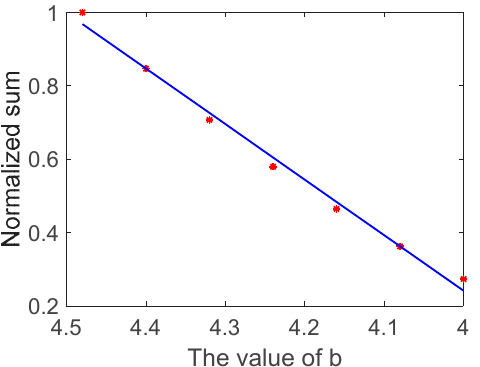
Figure 3. The relationship between the value of b and the normalized sum.